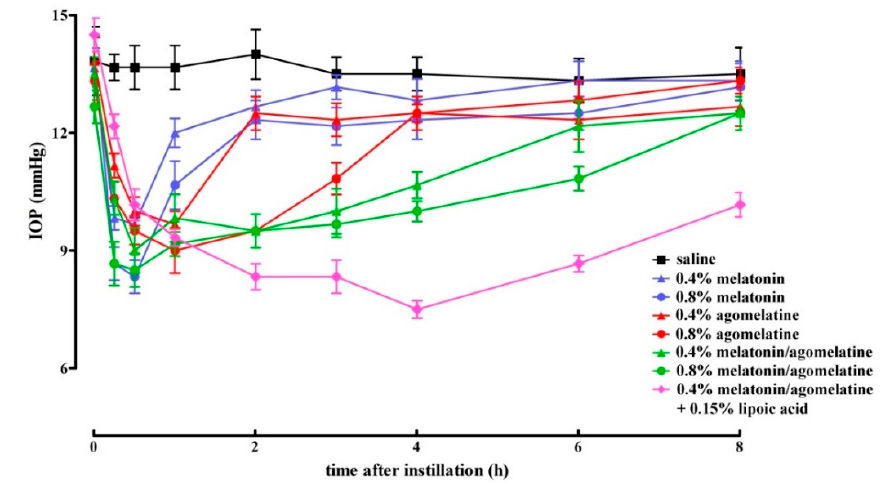
Figure 3. Lowering effect of different formulations of melatonin and agomelatine either alone or in combination without or with lipoic acid in rats with normotensive intraocular pressure. No difference in the magnitude of lowering effect could be assessed among the different concentrations and formulations. An increase in the concentration of melatonin and agomelatine, their combination or the addition of lipoic acid increased the duration of the lowering effect. Values represent the mean ± SEM of data from 3 rats (6 eyes).